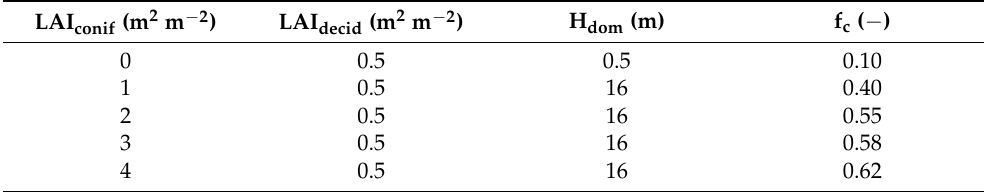
Table 2. Stand parameter combinations used in the simulations. LAI decid (one sided) was applied in the harvested treeless areas to account for the field layer vegetation. Canopy closure is the value for the unharvested forest stand (see Figure 2b–d) or completely forested layouts (see Figure 2e). In the case of LAI conif = 0 (harvested treeless strip or clear-cut area), dominant height (H dom ) and canopy closure (f c ) describe those of the field layer